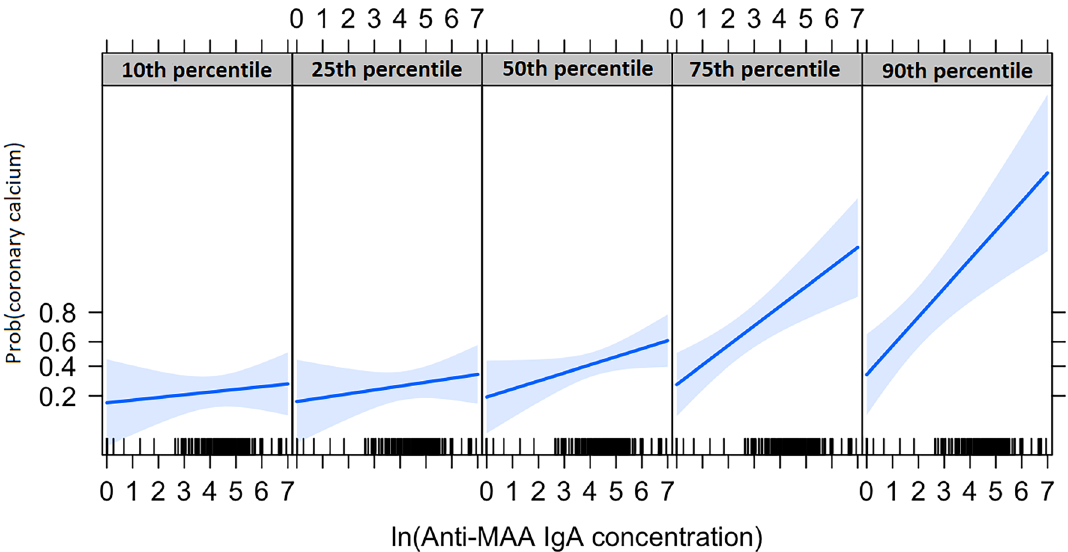
Figure 2. The interaction between anti-MAA IgA concentration and ACC/AHA 10-year risk score in predicting the presence of coronary artery calcium. Percentiles refer to the ACC/AHA 10-year risk score percentile of the RA patients. At higher ACC/AHA 10-year risk score, shown as 75th and 90th percentiles, presence of elevated anti-MAA IgA was associated with an amplified probability of coronary